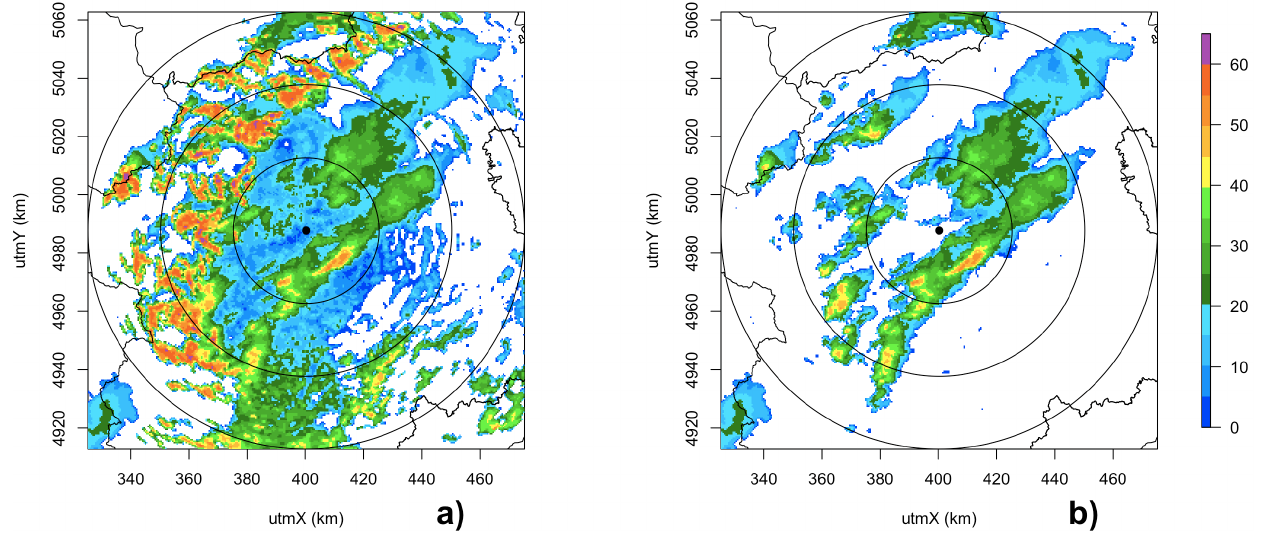
Figure 2. Maximum reflectivity map (projection to the ground of the maximum reflectivity along the vertical) from the Bric della Croce radar on 13 August 2010 at 20:20 UTC before ( a ) and after ( b ) the clutter removal procedure. The map is shown on a reduced 75 km range domain for clarity, with range rings overplotted every 25 km. The Alps (on the West and North side) and Apennines (South) are clearly visible in the original data (left panel), with peak reflectivities above 60